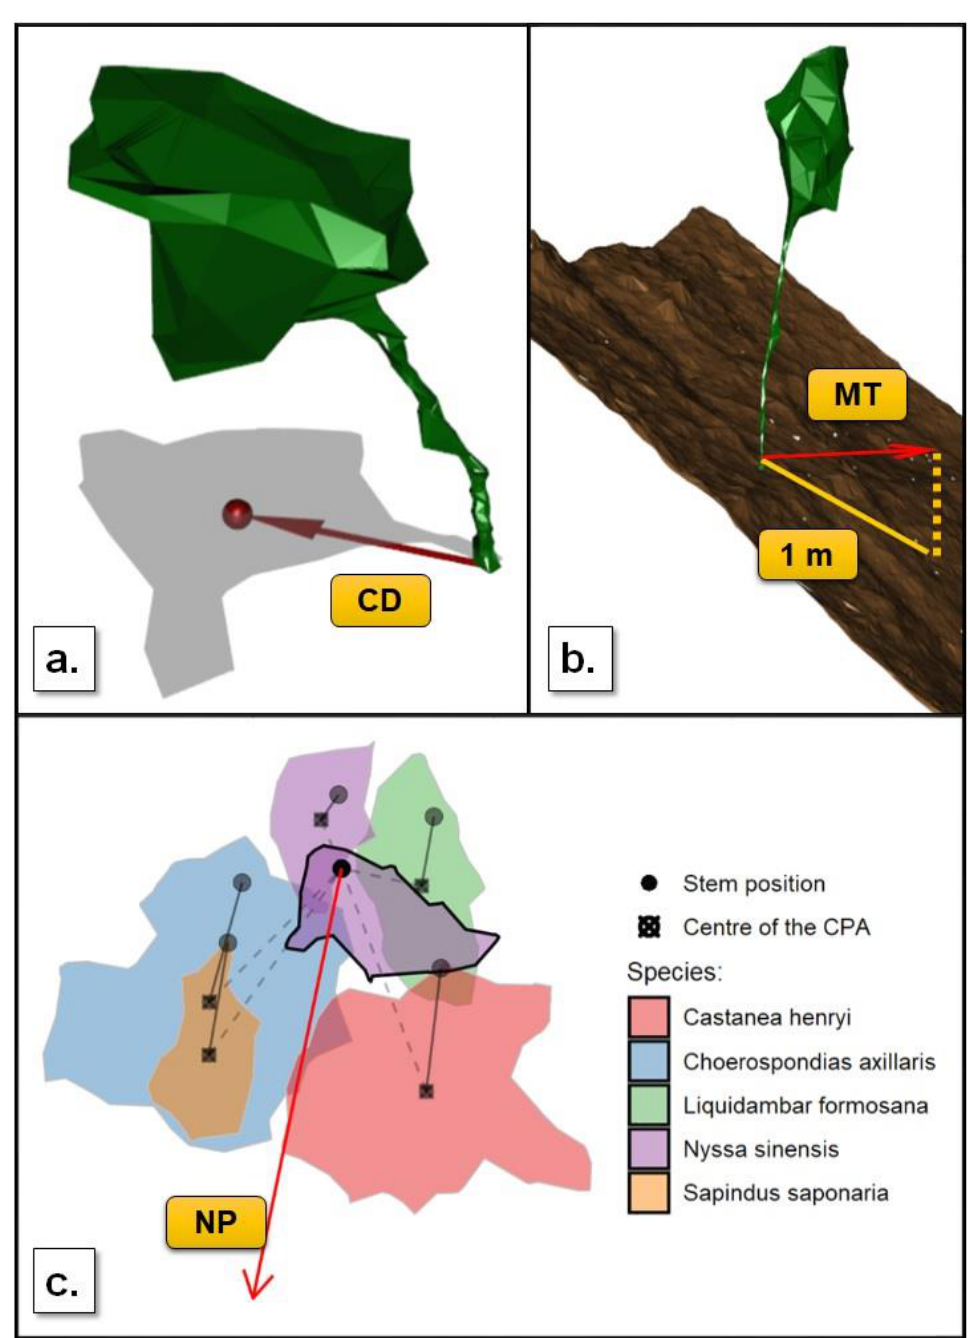
Figure 3. Graphic representation of ( a ) crown displacement, where the crown projection area is shown in grey, the centre is represented as a red dot, and the crown displacement is represented as a red arrow. In green is the alpha shape representation of an individual tree; ( b ) microtopography, showing in brown the terrain, in green the representation of an individual tree, and in red the vector of microtopography; and ( c ) neighbourhood pressure, showing the crown projection area of the target tree (with a black outline) and its direct neighbours. Dots represent the stem position, dots with a cross represent the centre of the crown projection area, solid lines represent the displacement of each neighbour, and dotted lines the pressure from the neighbour to the target tree. The red arrow represents the total neighbourhood pressure. Different polygon colours indicate different tree spe- cies.